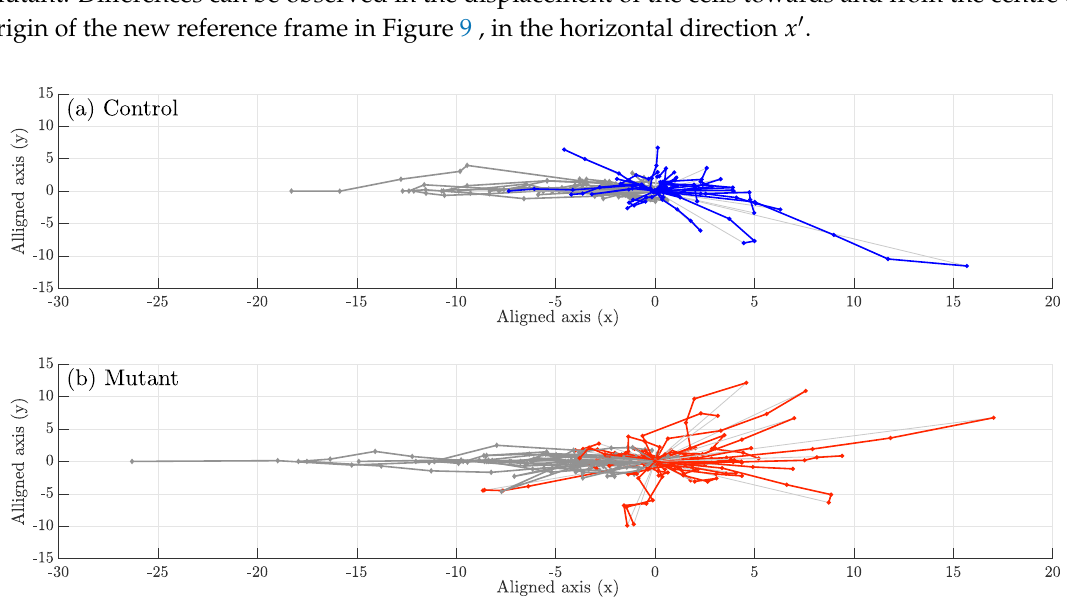
Figure 10. Comparison of aligned tracks for ( a ) control and ( b ) mutant interactions. Each line represents the trajectory of one cell, and the marker ( · ) represents the position at a certain time frame. Each line can be read from the utmost left point and continuing, initially towards the right, along the line to the next time frame marker. The grey lines correspond to the cells before entering clump , where the origin (0,0) corresponds to the clump formation. Red and blue lines correspond to five time frames of each cell after exiting the